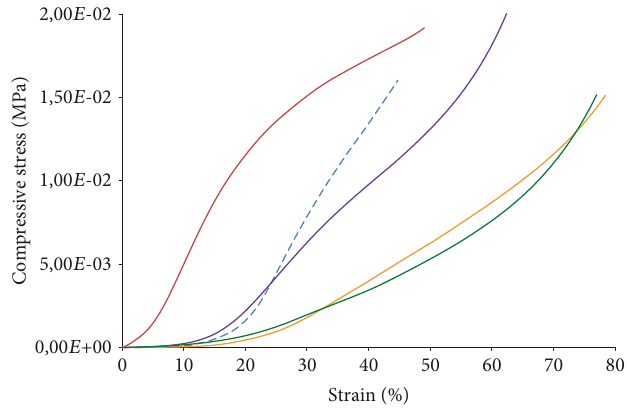
Figure 6: Stress curves in compression mode for the CS/WPI/Hap sca ff old obtained by the batch process (dotted blue line) and the /HAp sca ff old ( L = 30mL min − 1 , G = 50 mL min − 1 , and N = 600rpm ) (full red line), CS/WPI/HAp sca ff old CS/WPI/SiO 2 ( L = 30mL min − 1 , G = 50mL min − 1 , and N = 600 rpm ) (full violet line), CS/WPI/HAp sca ff old ( L = 30 mL min − 1 , G = 30 mL min − 1 , and N = 600 rpm ) (full orange line), and CS/WPI/HAp sca ff old ( L = 30 mL min − 1 , G = 70 mL min − 1 , and N = 600 rpm ) (full green line) obtained by foaming continuous process using NAGU